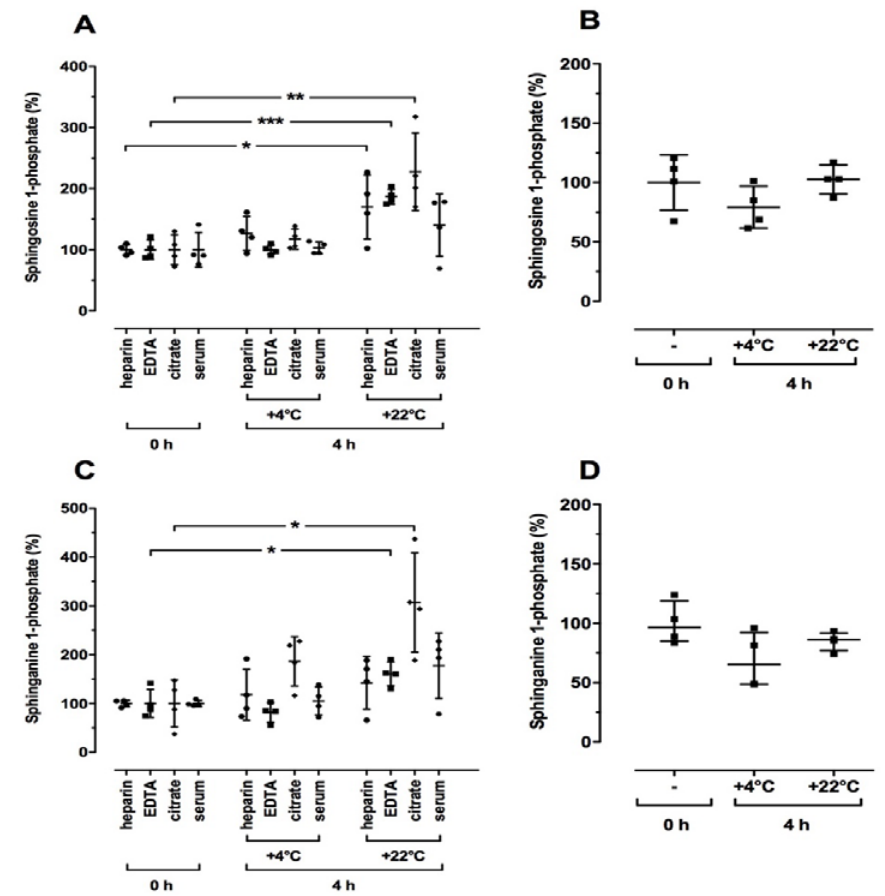
Figure 2. Temperature-dependent effect on relative sphingosine 1-phosphate ( A , B ) and sphinganine 1-phosphate ( C , D ) levels in human blood samples. Whole blood samples (heparin, EDTA, and citrate as anticoagulants or serum) were incubated for 4 h at the indicated temperatures ( A , C ). Thereafter, plasma and serum were isolated as described in the Material and Methods section. ( B , D ) Freshly isolated plasma (EDTA as anticoagulant) was incubated for 4 h at the indicated temperatures. Plasma and serum samples without storage time served as the respective controls (0 h; 100%). After final preparation, all samples were stored at − 80 °C until LC-MS/MS analysis. Data are shown as the mean (in %) ± SD ( n = 4). * p < 0.05, ** p < 0.01, *** p < 0.001. Table 3. Temperature-dependent effect on relative sphingolipid levels in human blood